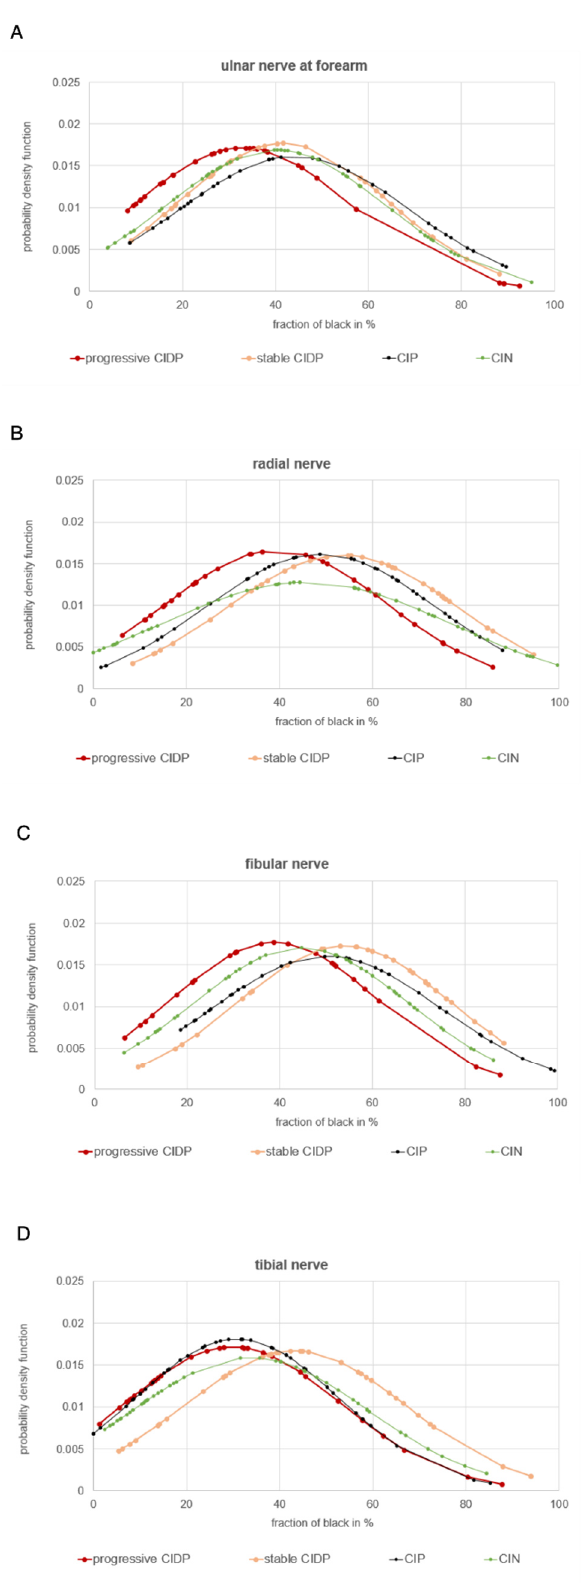
Figure 4. Distribution of echogenicity of the non-significant examination sites of patients with CIDP (progressive disease course = red, n = 8 and stable/regressive disease course = orange, n = 12) in comparison to patients with CIP (black, n = 19) and CIN (green, n = 27). ( A ) = ulnar nerve in forearm, ( B ) = radial nerve, ( C ) = fibular nerve, ( D ) = tibial nerve.